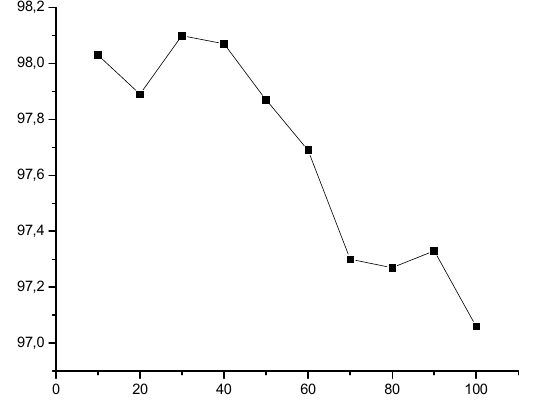
Figure.3.3. The average value of the objective function on swap probability